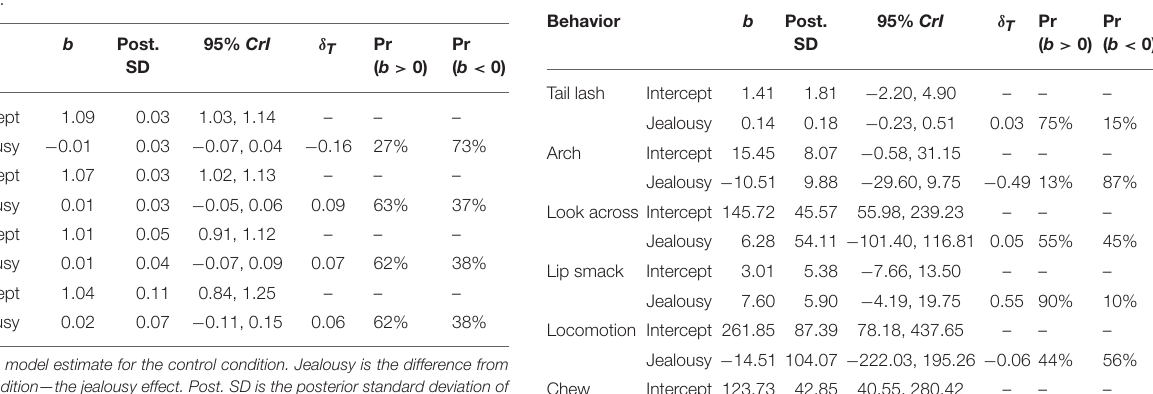
TABLE 6 | Multivariate multilevel model estimates for behaviors (duration).